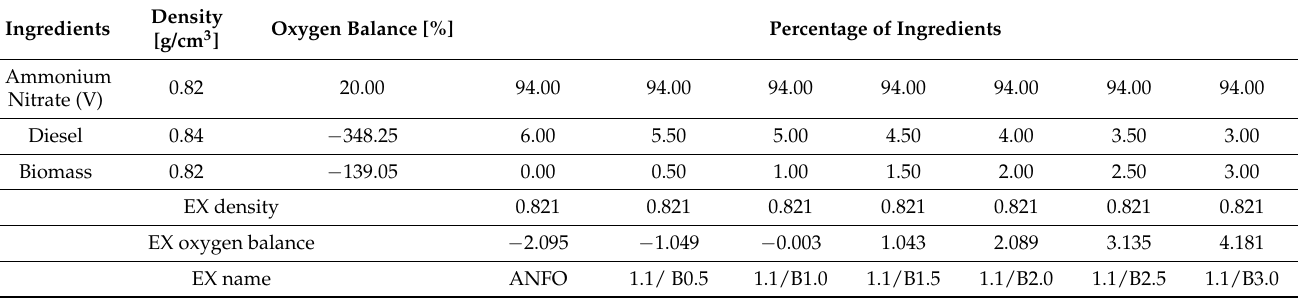
Table 1. Oxygen balance and EX density of ANFO type with addition of biomass for variant 1.1.